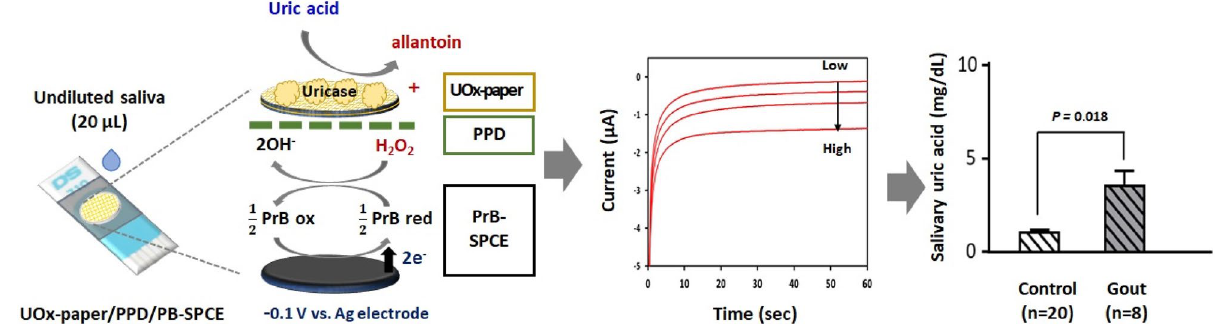
Figure 1. Schematic representation of the sensing principle and resulting current signal of the UOx-paper- based electrochemical UA sensor, and uric acid concentrations (mg/dL) in human saliva